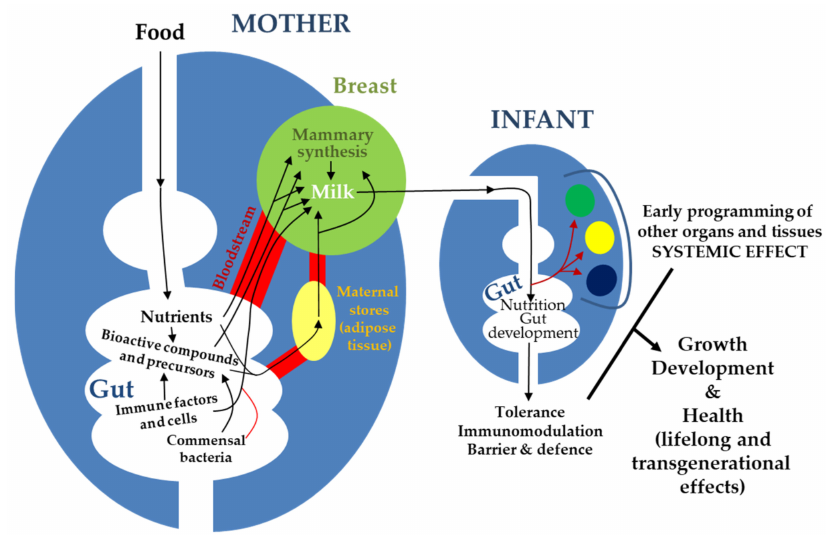
Figure 1. Schematic representation of the complex interactions between maternal gut, milk, and infant gut and their relevance for infant growth, development, and health.